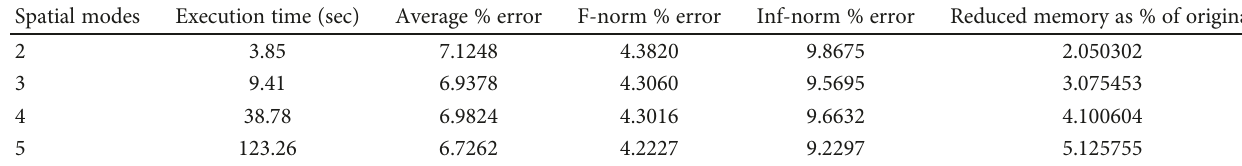
Table 9: Density in an y × z plane with i = 50 .